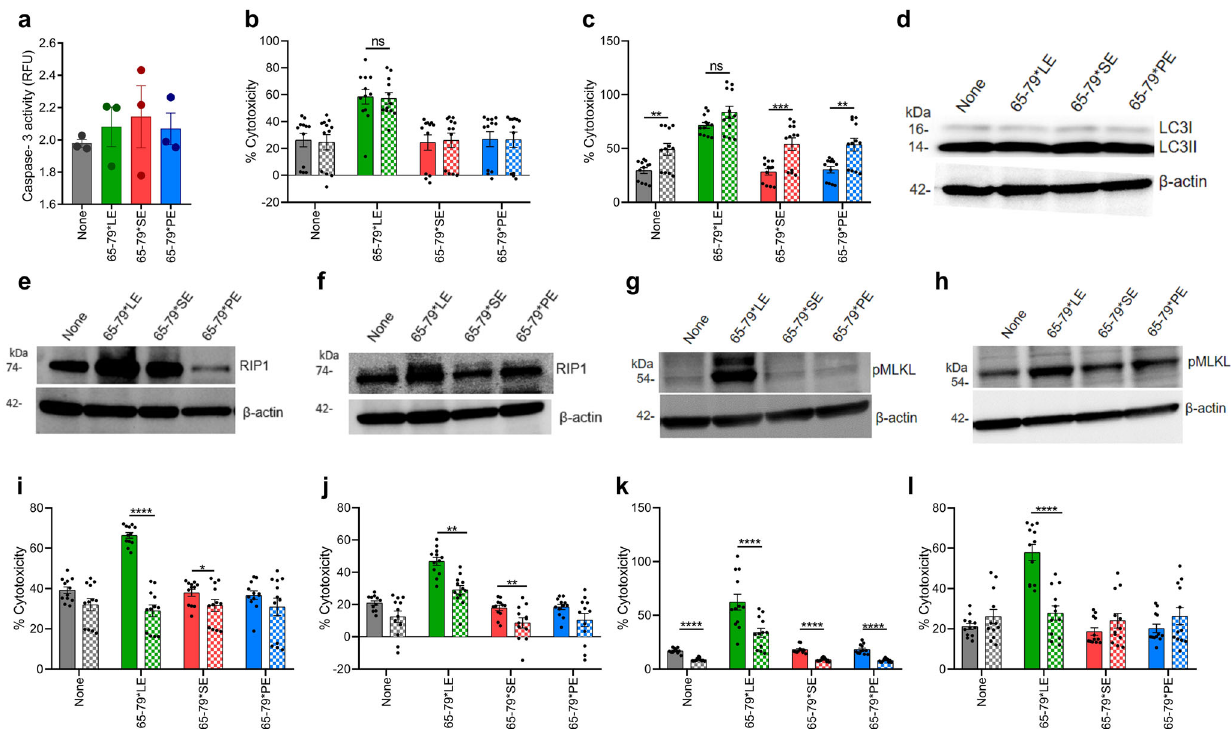
Fig. 5 The LE triggers necroptotic cell death in an allele-speci fi c fashion. a Caspase-3 activity in THP-1 macrophages ( n = 3). b Cell death in THP-1 macrophages in the absence (solid bars) or presence (dotted bars) of pan-caspase inhibitor ZVAD-FMK (10 µ M) ( n = 3). c Cell death in THP-1 macrophages in the absence (solid bars) or presence (dotted bars) of rapamycin (50 nM) ( n = 3). d Immunoblot of LC3 in RAW 264.7 macrophages. e Immunoblot of Receptor-Interacting Protein 1 (RIP) in RAW 264.7 macrophages. f Immunoblot of RIP in THP-1 macrophages. g Immunoblot of pMLKL in RAW 264.7 macrophages. h Immunoblot of pMLKL in THP-1 macrophages. i Cell death of RAW 264.7 macrophages in the presence (dotted bars) or absence (solid bars) of the RIP1 inhibitor Necrostatin-1 (50 μ M) ( n = 3). j Cell death of THP-1 macrophages in the presence (dotted bars) or absence (solid bars) of the RIP1 inhibitor Necrostatin-1 (50 μ M) ( n = 3). k Cell death of RAW 264.7 macrophages in the presence (dotted bars) or absence (solid bars) of the MLKL inhibitor Necrosulfonamide (10 μ M) ( n = 3). l Cell death of THP-1 macrophages in the presence (dotted bars) or absence (solid bars) of the MLKL Inhibitor Necrosulfonamide (10 μ M) ( n = 3). Blots ( d – h ) are representative of 3 independent experiments each. Uncropped immunoblots are